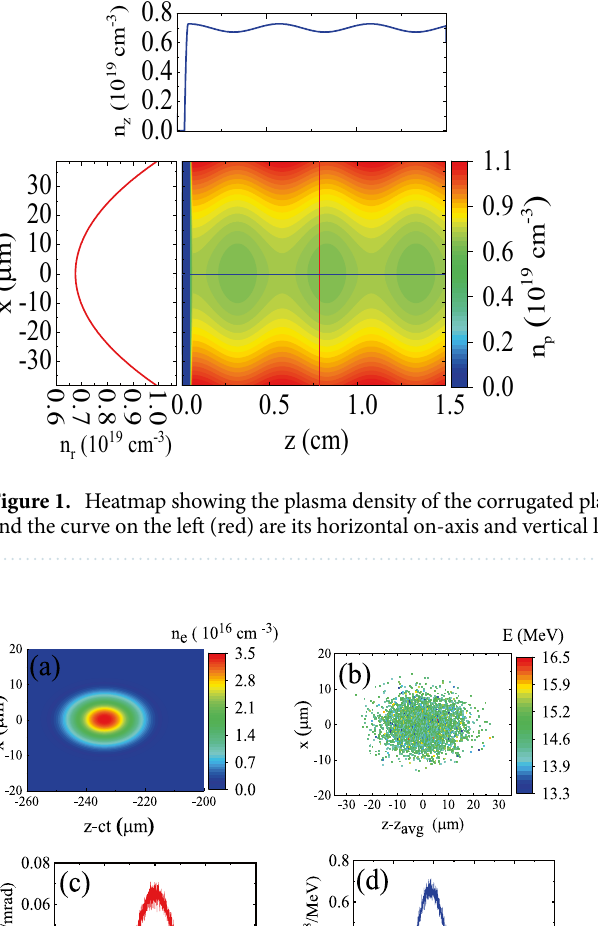
where var ( x ) , var ( P x ) and cov ( x , P x ) respectively denote the variance of the positions, the variance of the momenta, and their covariance, in the transverse direction. When post-processing the raw outputs of the simu- lations to calculate distributions and quantities like energy spectrum and emittance, only those particles which are not farther from the axis than 15 μm are taken into account. This is comparable to placing a collimator at the end of the waveguide in an experiment. By increasing this radius in post-processing, emittance is increased, but our investigation show that the general conclusions of this paper are independent of the radius used in post-processing.